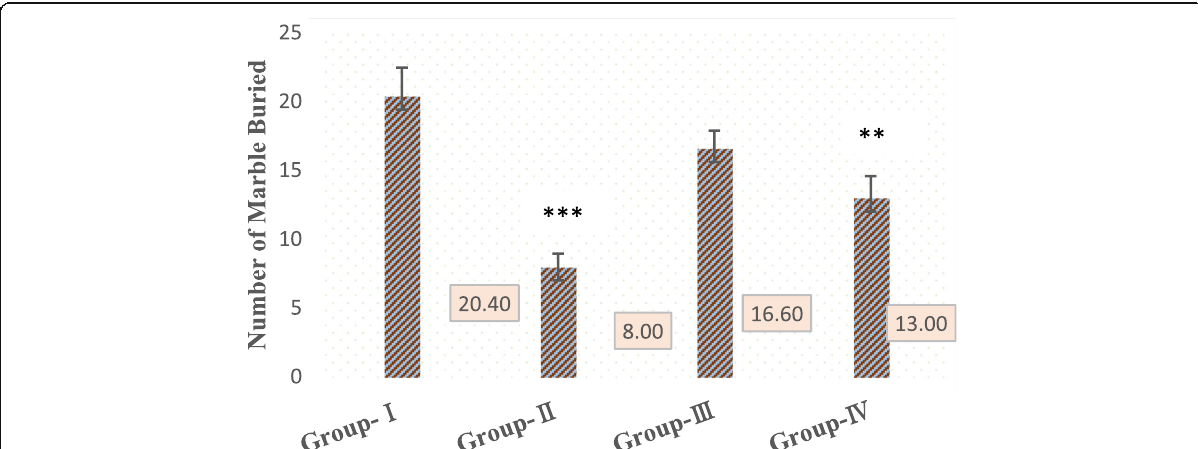
Fig. 4 Effect of Psidium guajava Linn leaves extract on the number of marble buried in the saw dust in Marble-Burying Behavior model. Group I